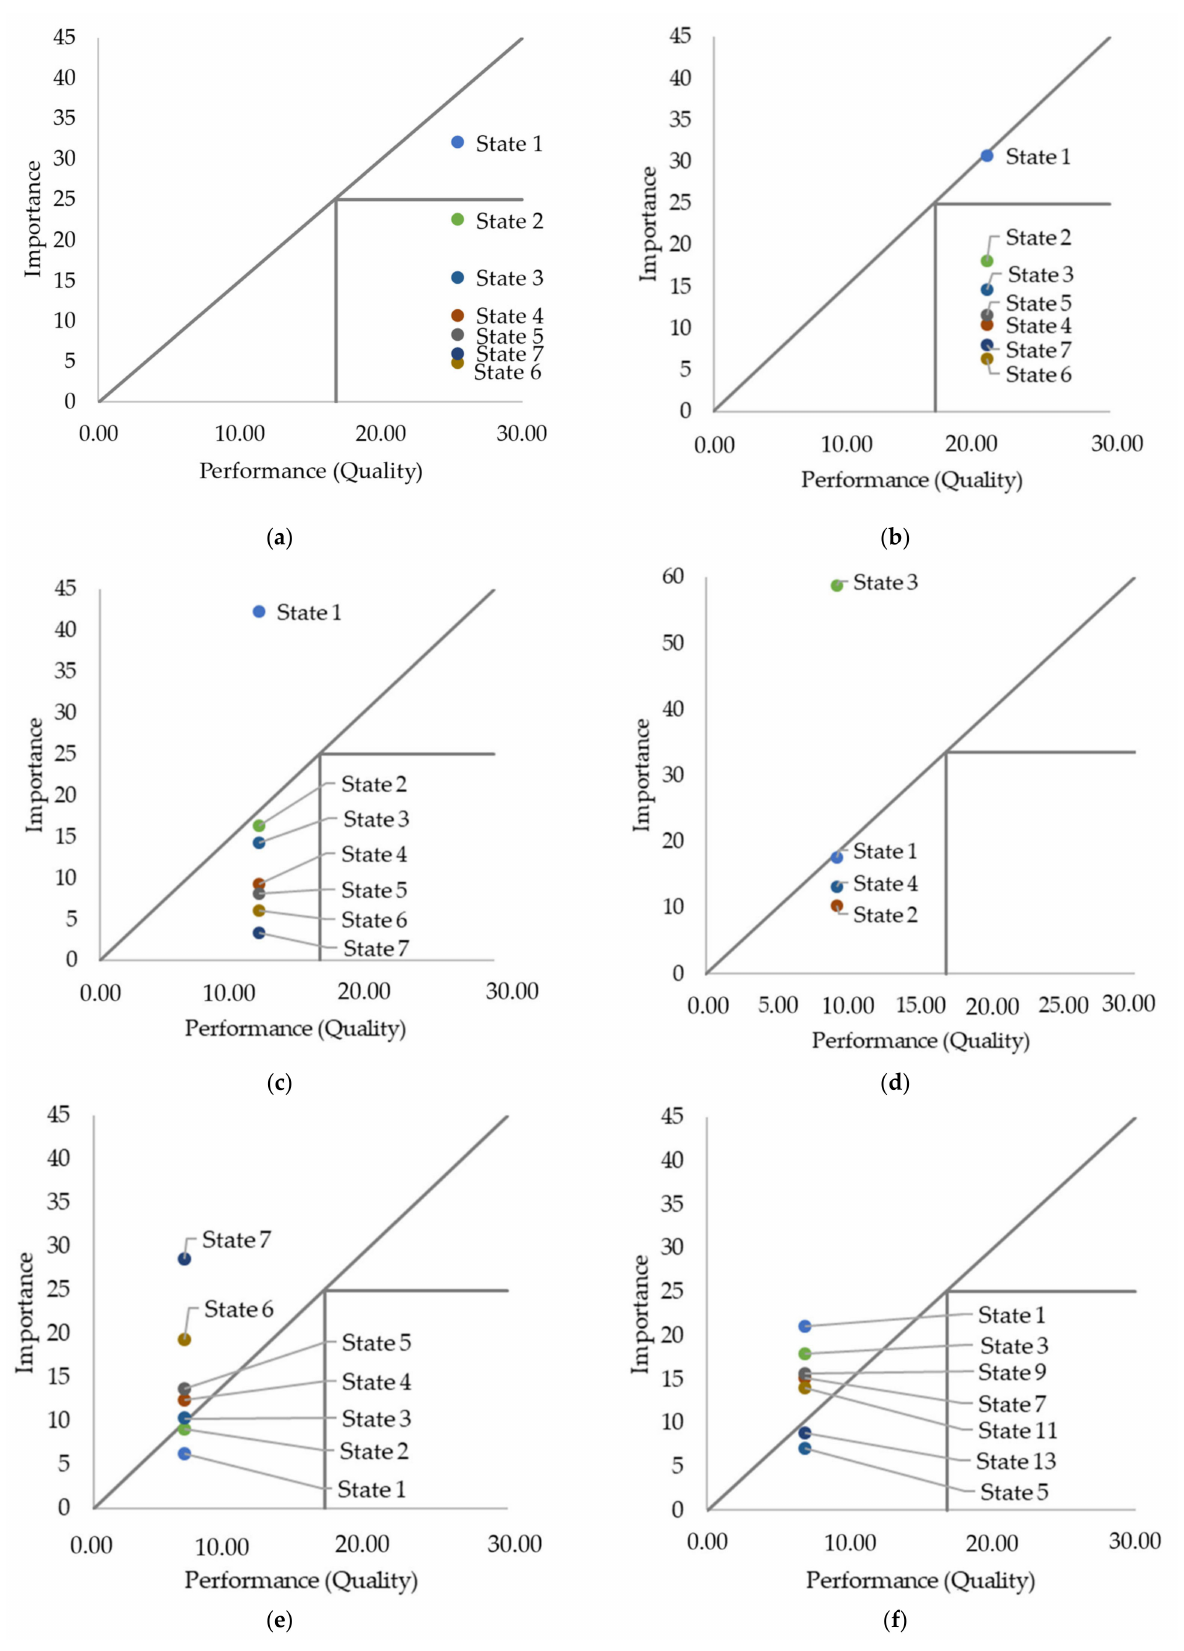
Figure 6. IPA charts for the PV criteria states: ( a ) short-circuit electricity, ( b ) peak power, ( c ) maximum current, ( d ) idle voltage, ( e ) weight, ( f )